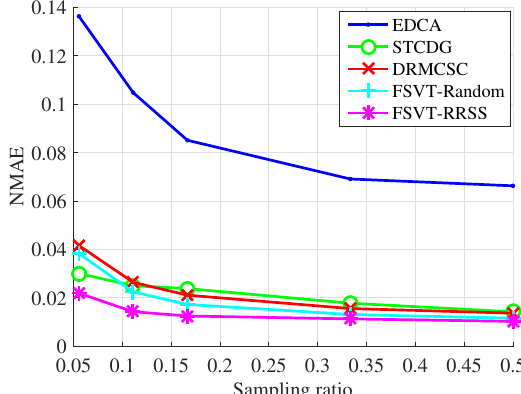
Figure 5. NMAE over sampling ratio for the temperature from Intel Berkeley Research Lab.